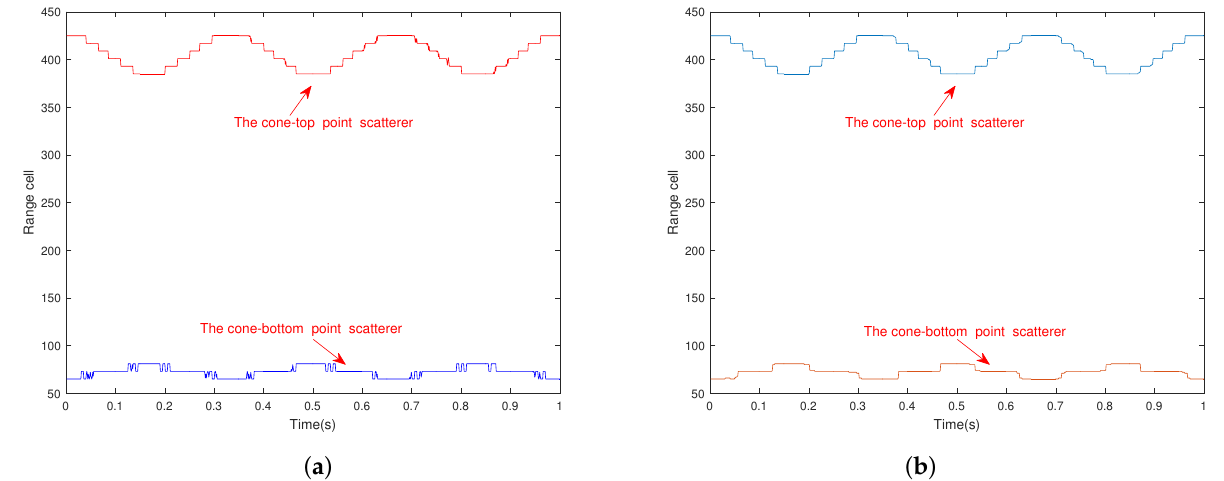
Figure 5. Envelope extraction: ( a ) envelope extraction using HO-MF-TBD method; ( b ) envelopes after median filtering.